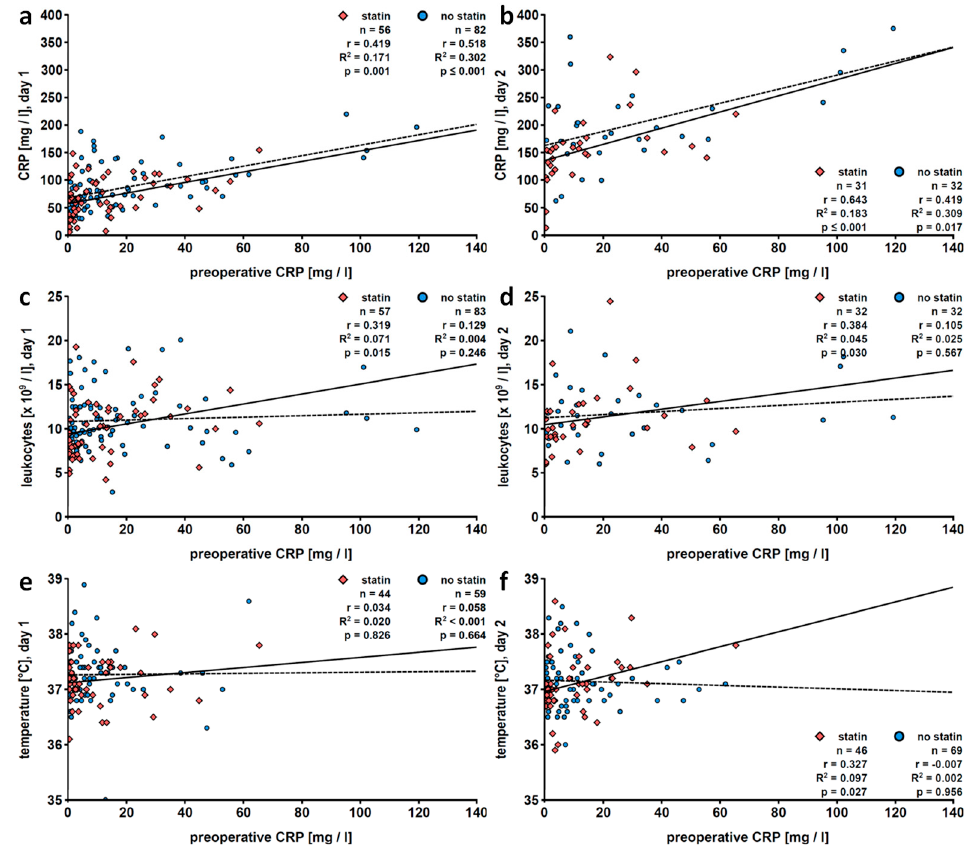
Figure 5. Male patients stratified according to statin intake: linear regression analyses of preoperative levels of C-reactive protein (CRP) with postoperative CRP levels ( a , b ), blood leukocyte counts ( c , d ) or fever ( e , f ). Patients who underwent pulmonary resection were investigated retrospectively and data collected on the first ( a , c , e ) and the second ( b , d , f ) postoperative day are depicted. Preoperative CRP values were obtained within 7 days before surgery. The solid line represents the best fit line for data patients treated with statins and the dashed line for those of patients who do not take statins. r, correlation coefficient; R 2 , coefficient of determination.